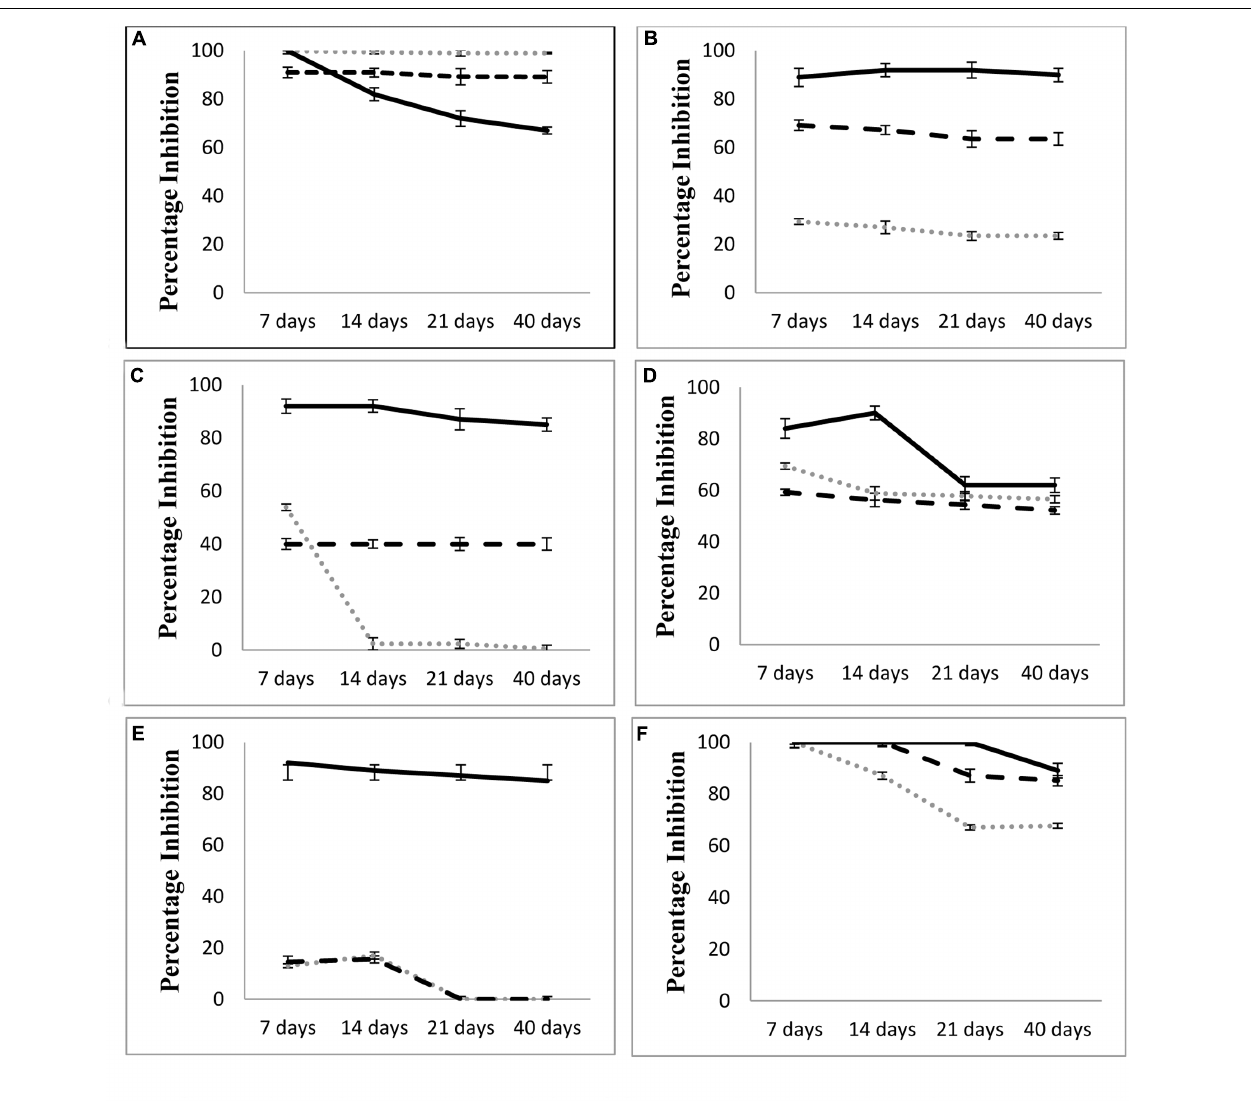
FIGURE 6 | Comparison of antagonistic activity of Compound 1; 2 pentyl 4 quinolone carboxylic acid with L. sphaericus isolate and fungicide Benlate at different time points against (A) Alternaria alternata , (B) Curvularia lunata , (C) Aspergillus sp., (D) Sclerotinia sp., (E) Bipolaris spicifera , (F) Trichophyton